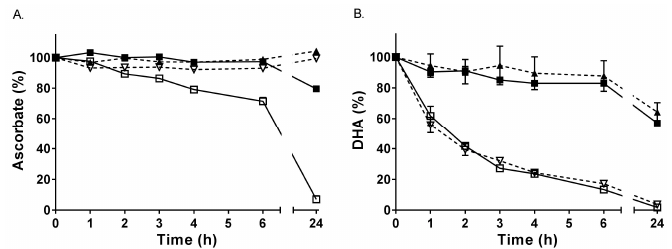
Figure 1. Stability of ascorbate and DHA in PBS. ( A ) Ascorbate (50 µ mol/L) was incubated on ice ( (cid:4) , (cid:78) ) or at room temperature ( (cid:3) , (cid:53) ) in the absence (solid line) or presence (dashed line) of the metal chelator DTPA (100 µ mol/L). ( B ) DHA (50 µ mol/L) was incubated on ice ( (cid:4) , (cid:78) ) or at room temperature ( (cid:3) , (cid:53) ) in the absence (solid line) or presence (dashed line) of DTPA (100 µ mol/L). Samples were analysed for ascorbate spectrophotometrically (following reduction of DHA with DTT) at the indicated time points. Data represent the mean ± SEM ( n = 3). Repeated measure one-way ANOVA with Dunnett’s test for multiple comparison showed no significant loss of ascorbate on ice over 6 h ( p = 0.697), but a significant decrease at room temperature from 2 h (in the absence of DTPA, p = 0.030). A small but significant decrease in DHA on ice was observed from 3 h ( p = 0.042) and a large decrease in DHA at room temperature was observed from 1 h ( p =